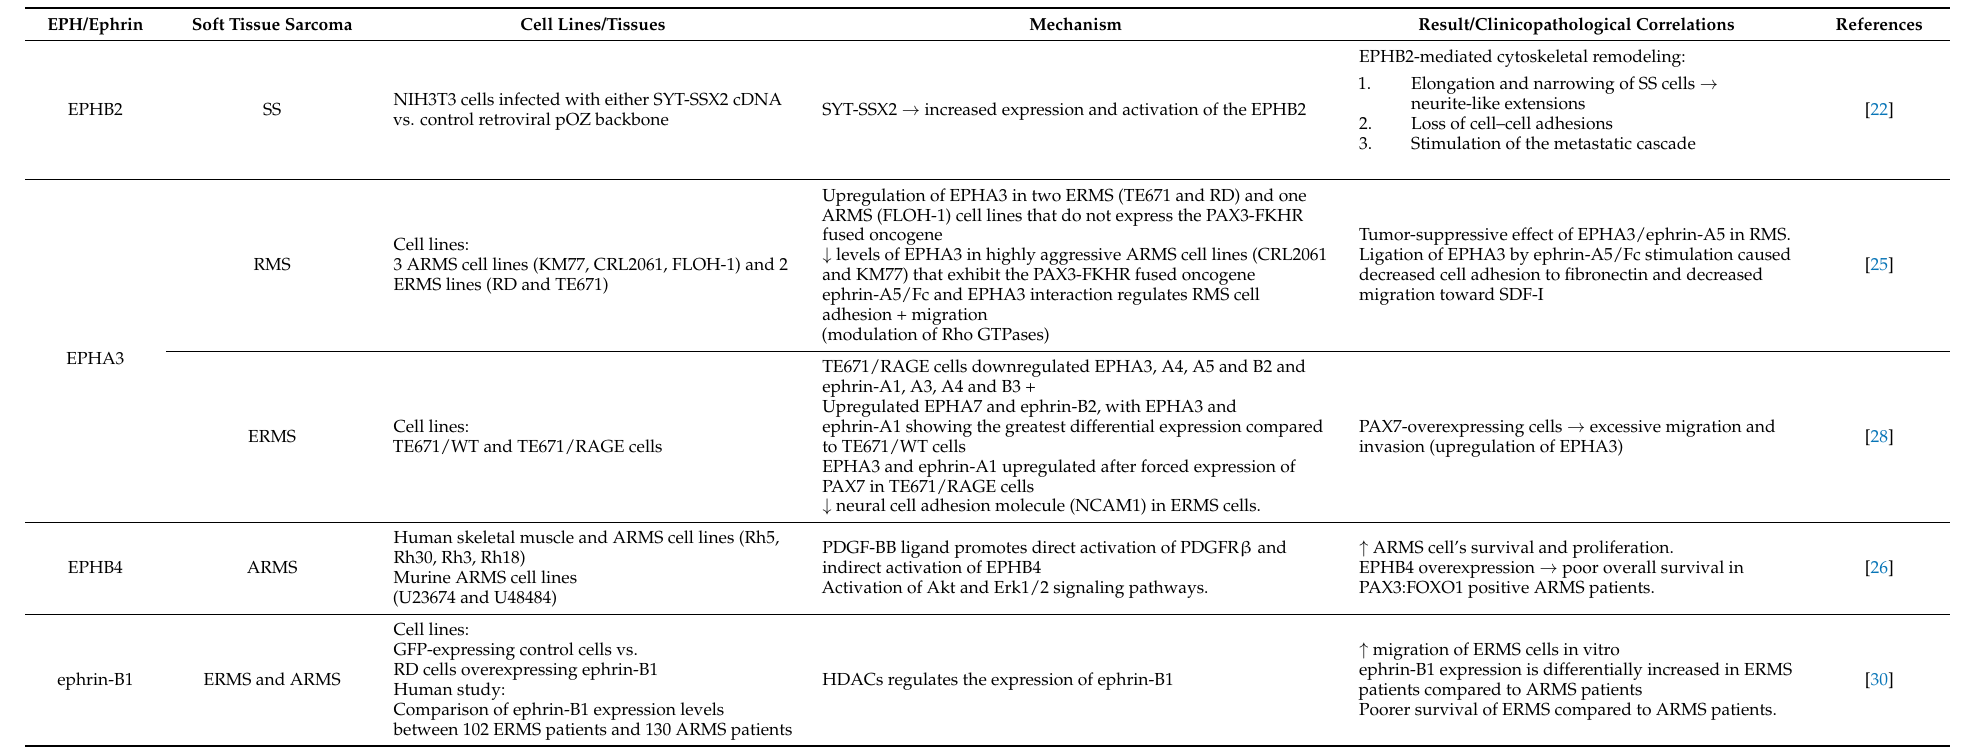
Table 2. Molecular mechanisms involving the EPH/ephrin axis in soft tissue sarcomas leading to specific laboratory and clinicopathological